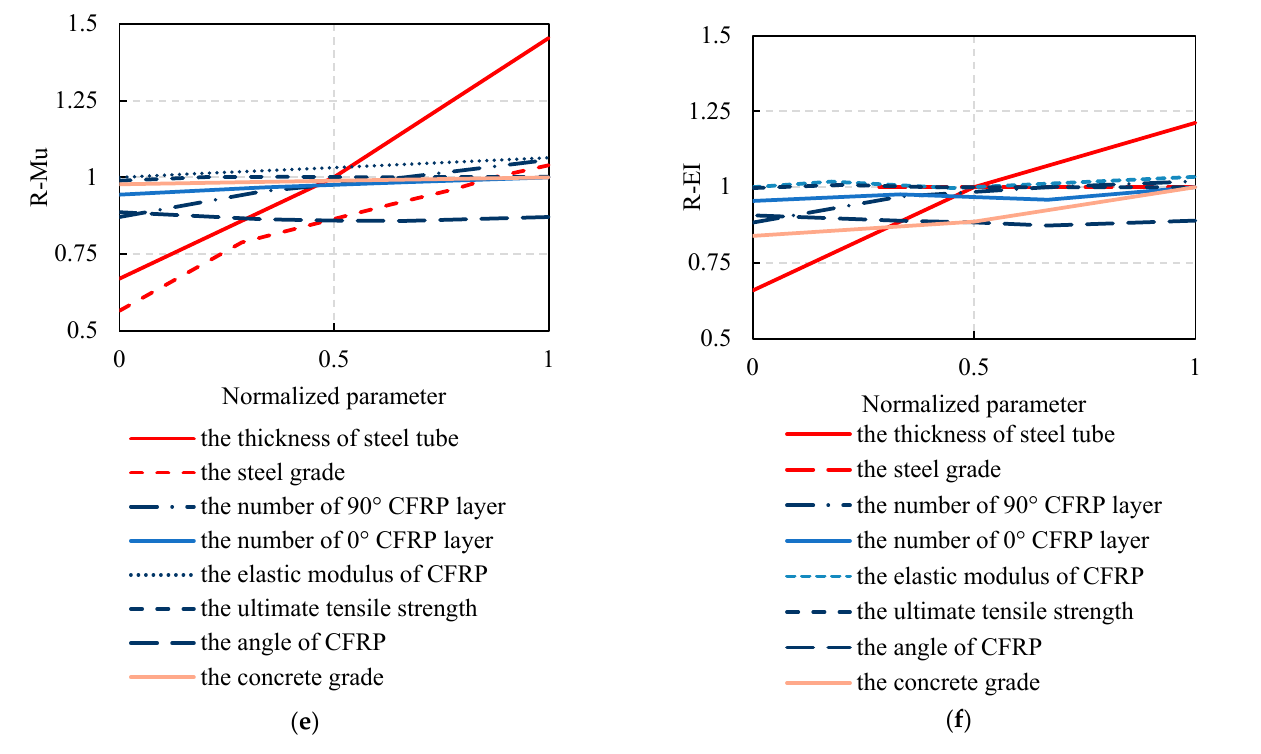
Figure 12. Sensitivity analysis of different design parameters: ( a ) Compressive load-bearing capac- ity. ( b ) Elastic compressive stiffness. ( c ) Tensile load-bearing capacity. ( d ) Elastic tensile stiffness. ( e ) Ultimate flexural capacity. ( f ) Elastic bending stiffness.